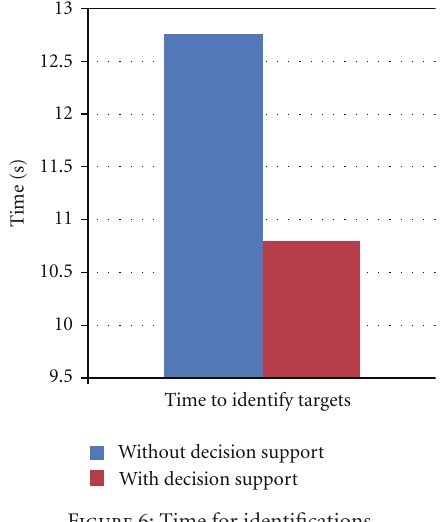
Figure 8: Accuracy of classifications.